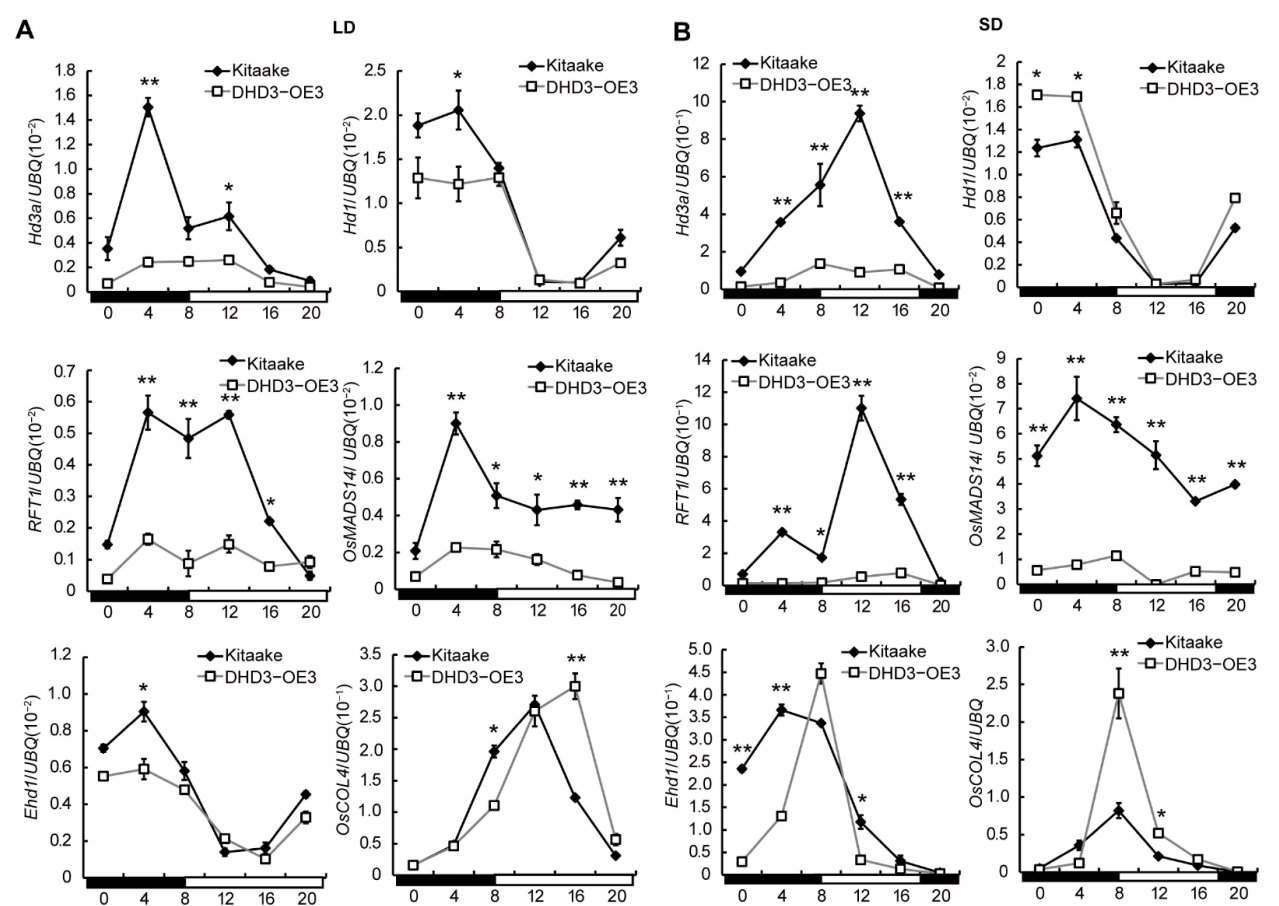
Figure 5. The expression levels of Hd3a , RFT1 , OsMADS14 , Ehd1 , OsCOL4 , and Hd1 in WT (Kitaake) and DHD3–OE3 plants under LD ( A ) and SD ( B ) conditions. The black and white boxes denote dark and light periods, respectively. Data are means ± s.e. of three biological replications. Statistical significance is indicated by * p ≤ 0.05 and ** p ≤ 0.01; one-way ANOVA test with Tukey